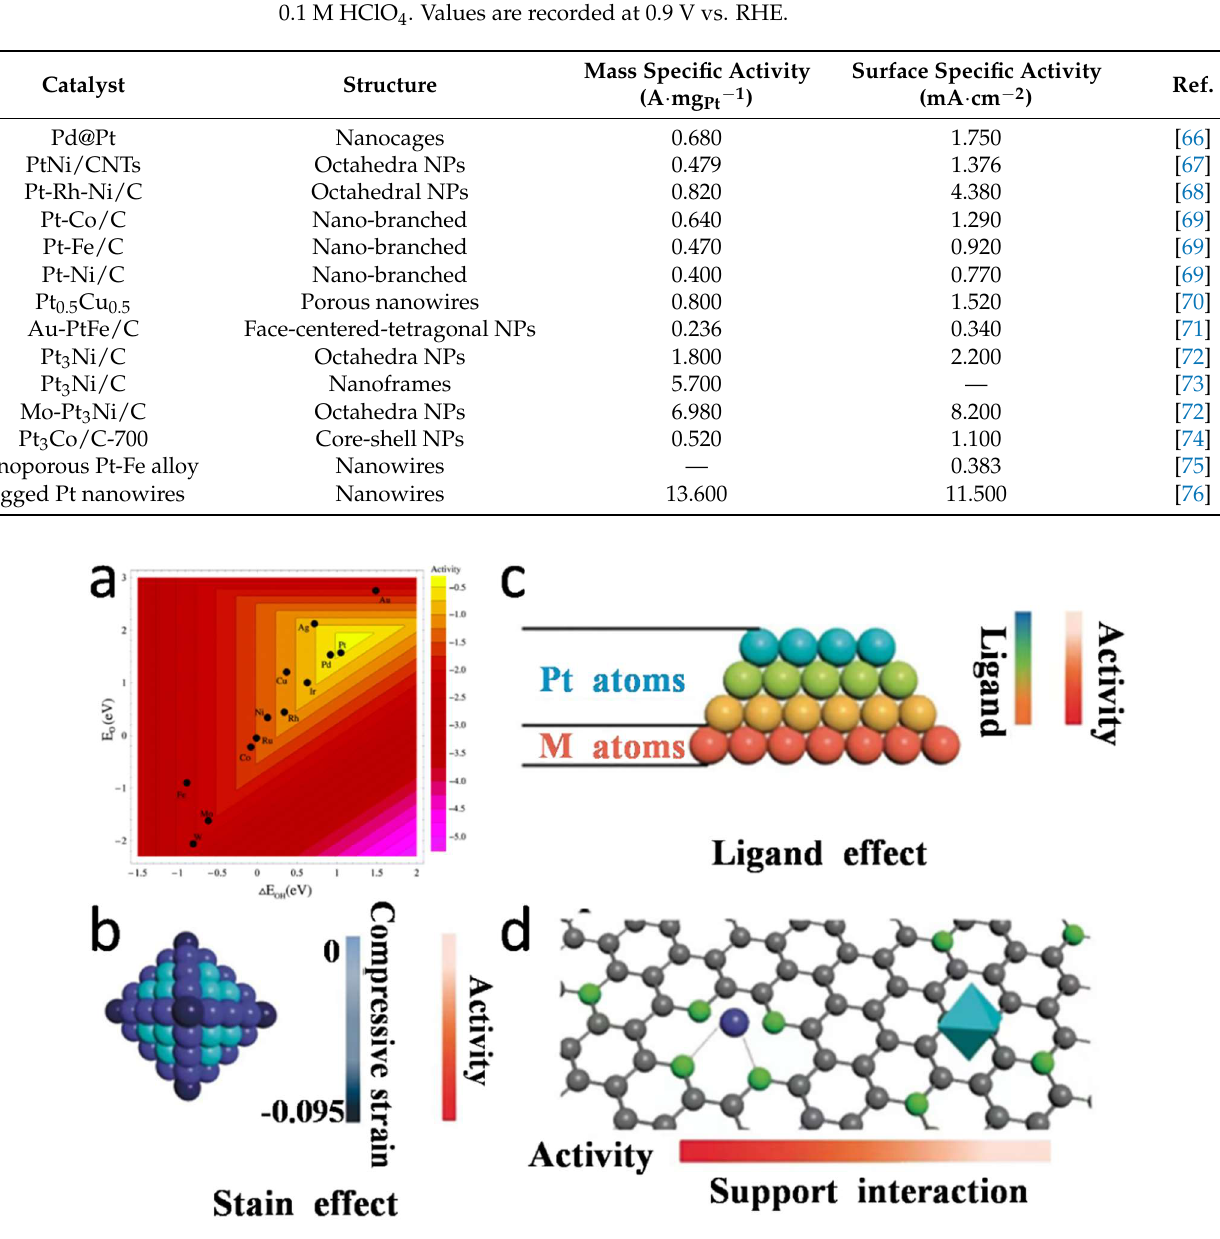
Figure 2. ( a ) Trend of ORR activity plotted as a function of the binding energies of the O and OH. Reproduced from ref. [56] with permission from American Chemical Society, copyright 2004. The schematic diagram of the theoretical mechanism is as follows: ( b ) Strain effect, which refers to the surface strain distribution and the resulting relative activity; ( c ) Ligand effect, which gradually decreases with the increasing number of Pt atomic layers, almost disappearing after more than 3 layers; Reproduced from ref. [65] with permission from American Chemical Society, copyright 2012. ( d ) Support interaction, which refers to the anchoring of a single Pt atom (blue) and the Pt NPs (octahedron) supported by heteroatom (green) doped C (gray). Reproduced from ref. [60] with permission from Wiley-VCH, copyright 2020. Table 1. The mass specific activities and surface specific activities of various Pt-based catalysts un- der 0.1 M HClO 4 . Values are recorded at 0.9 V vs. RHE.